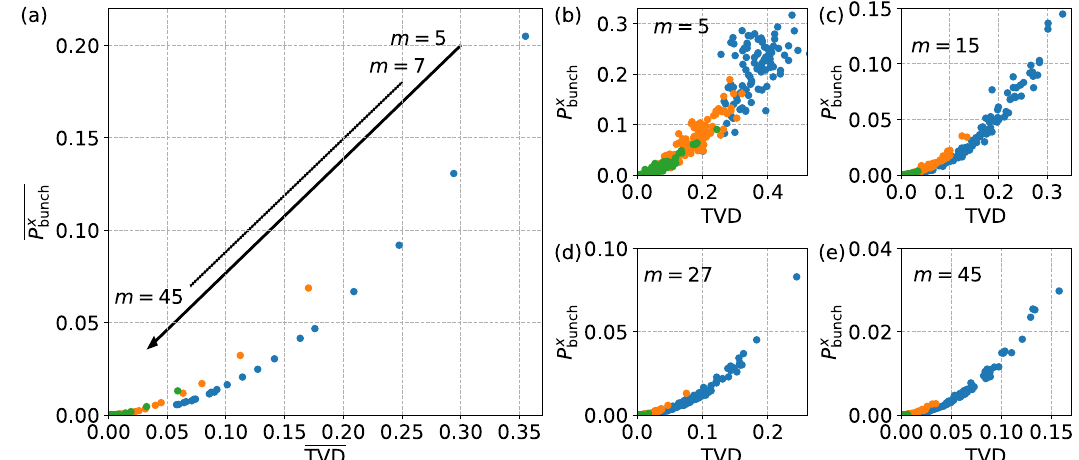
Fig. 3 Simulation in the fi nite setting. Analysis of total variation distance (TVD) between the non-linear process and its linear-optical simulation, and bunching probability at the non-linear phase shift site for n = 4 photons. The TVD is calculated between the exact probability distribution [Eq. (4)], and the post-selected linear-optical simulation using k < n auxiliary photons. In these plots, the exact distribution is calculated using the linear-optical simulation scheme with n auxiliary photons. P x nonlinearity site x . a Parametric plot showing a correlation between the mean values TVD and P x and V for fi xed ϕ = π /2. Each point corresponds to a different value of m , in the range [5, 7, … , 45]. b – e Correlation between TVD and P x fi xed number of modes m . Here, each point corresponds to different evolutions W and V for fi xed ϕ = π /2. In all plots: blue points correspond to k = 1, orange points to k = 2, and green points to k =